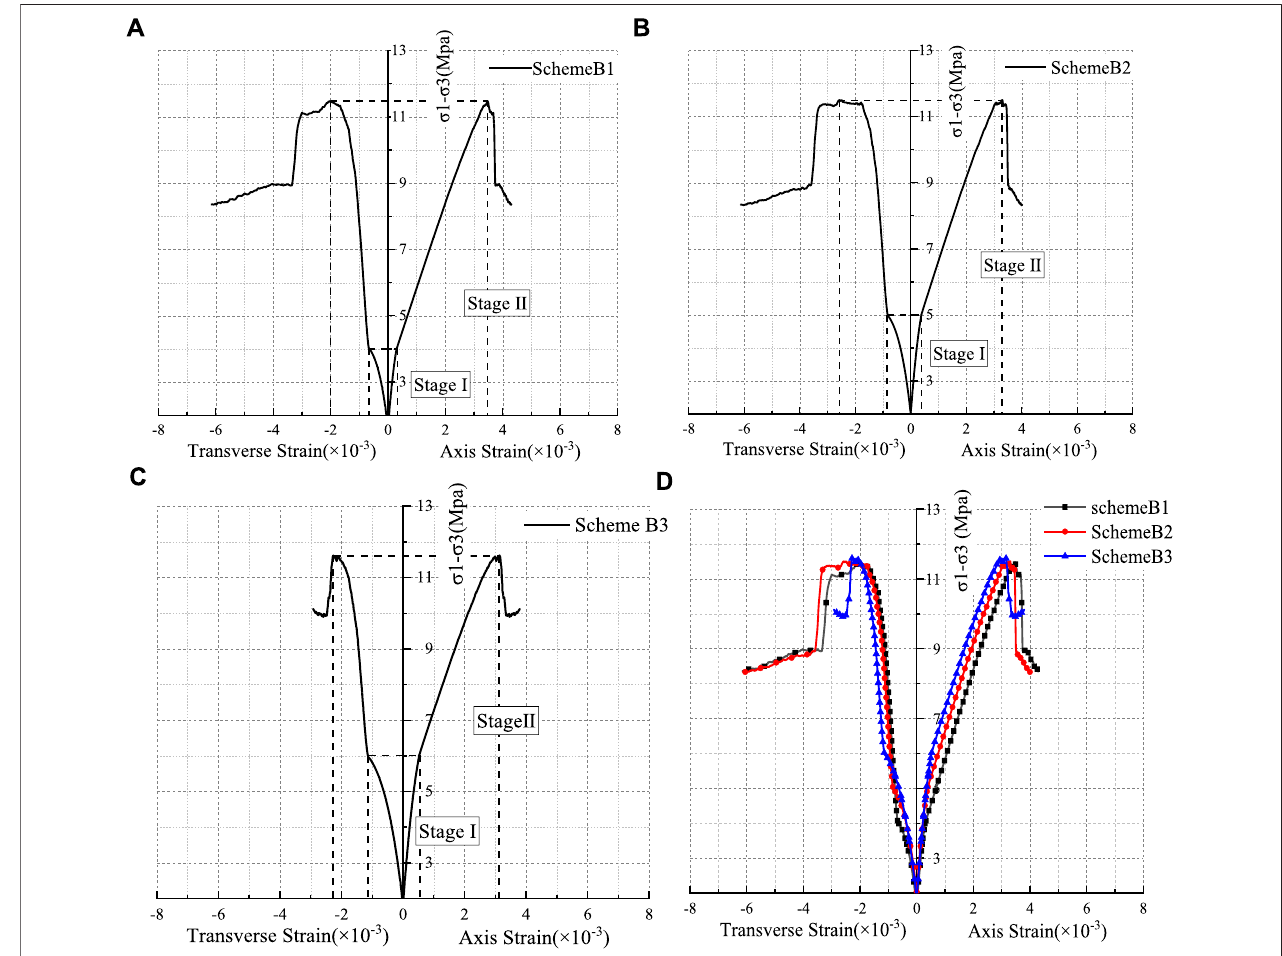
FIGURE6| Deformationcharacteristics oftherockmasswithdifferentdepthandplanB. (A) LoadingschemeB1; (B) loadingschemeB2; (C) loadingschemeB3; and (D) comparison curves.